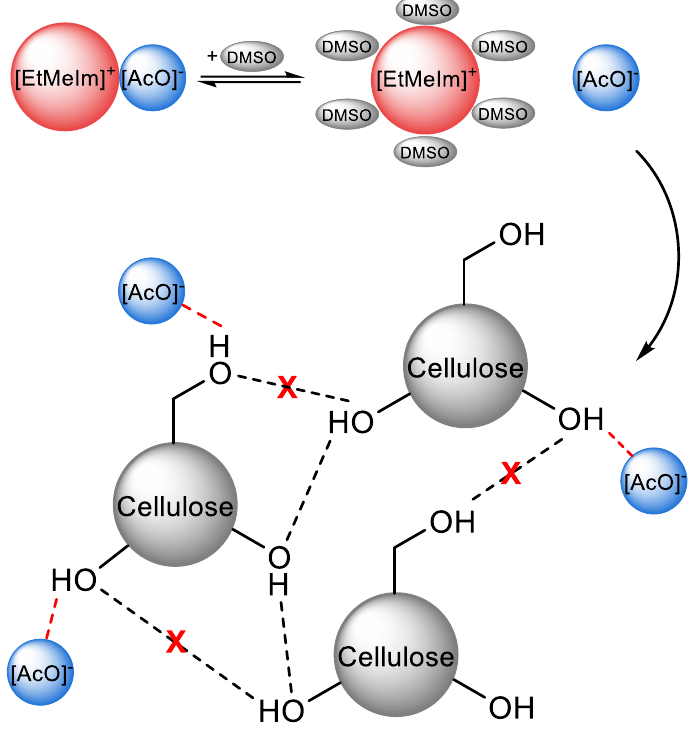
Figure 3. Schematic representation of the mechanism of cellulose dissolution in 1-ethyl-3-methylimidazolium acetate-dimethyl sulfoxide (EtMeImAcO-DMSO) mixture. The ionic liquid (IL) cation is solvated by DMSO and associated with the negatively charged cellulose-acetate ion H-bonded complex, redrawn from [41], with permission from Springer, 2016.